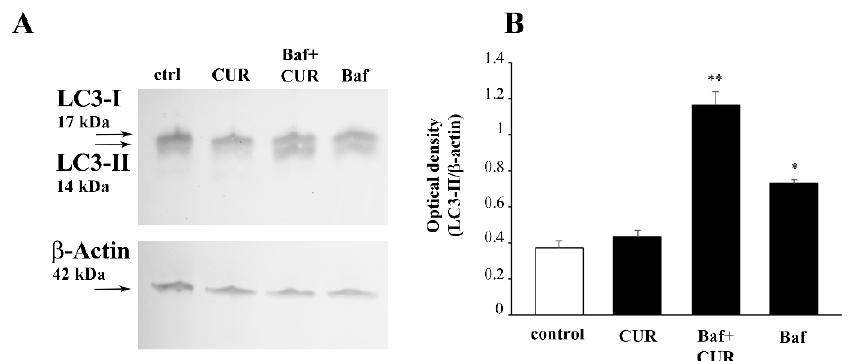
Figure 15. CUR induces autophagy. ( A ) WB for LC3-II levels and ( B ) related optical density graph in PC12 cells treated with CUR and the late autophagy inhibitor bafilomycin A1. Ctrl = control; Baf = bafilomycin A1 * p < 0.05 compared with control; ** p < 0.05 compared with control and